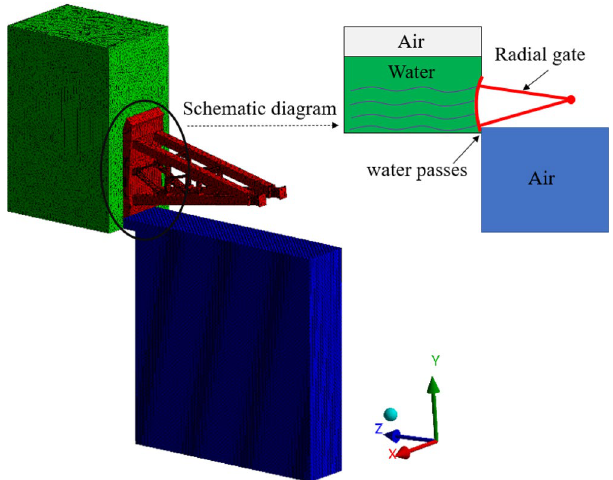
Figure 4. Structure of finite element calculation model for radial